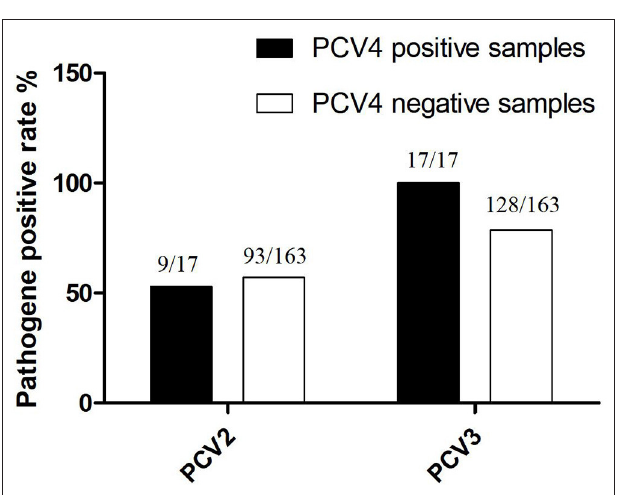
FIGURE 3 | The co-positive rate of PCV4 with PCV2 and